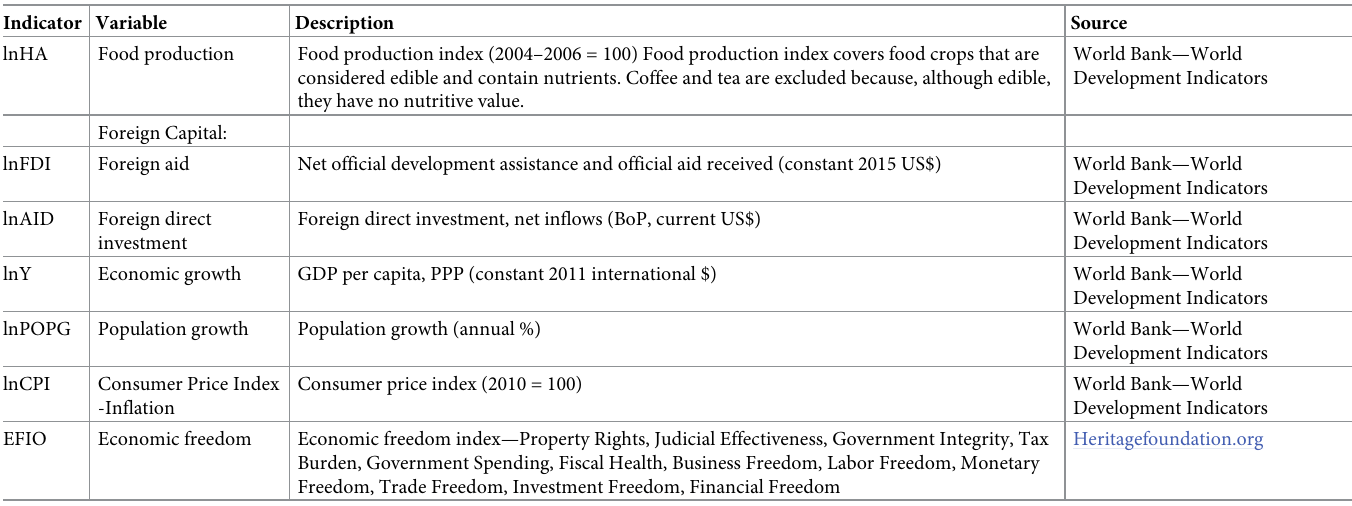
Table 1. Variables description and sources (Source: Authors’ construct).